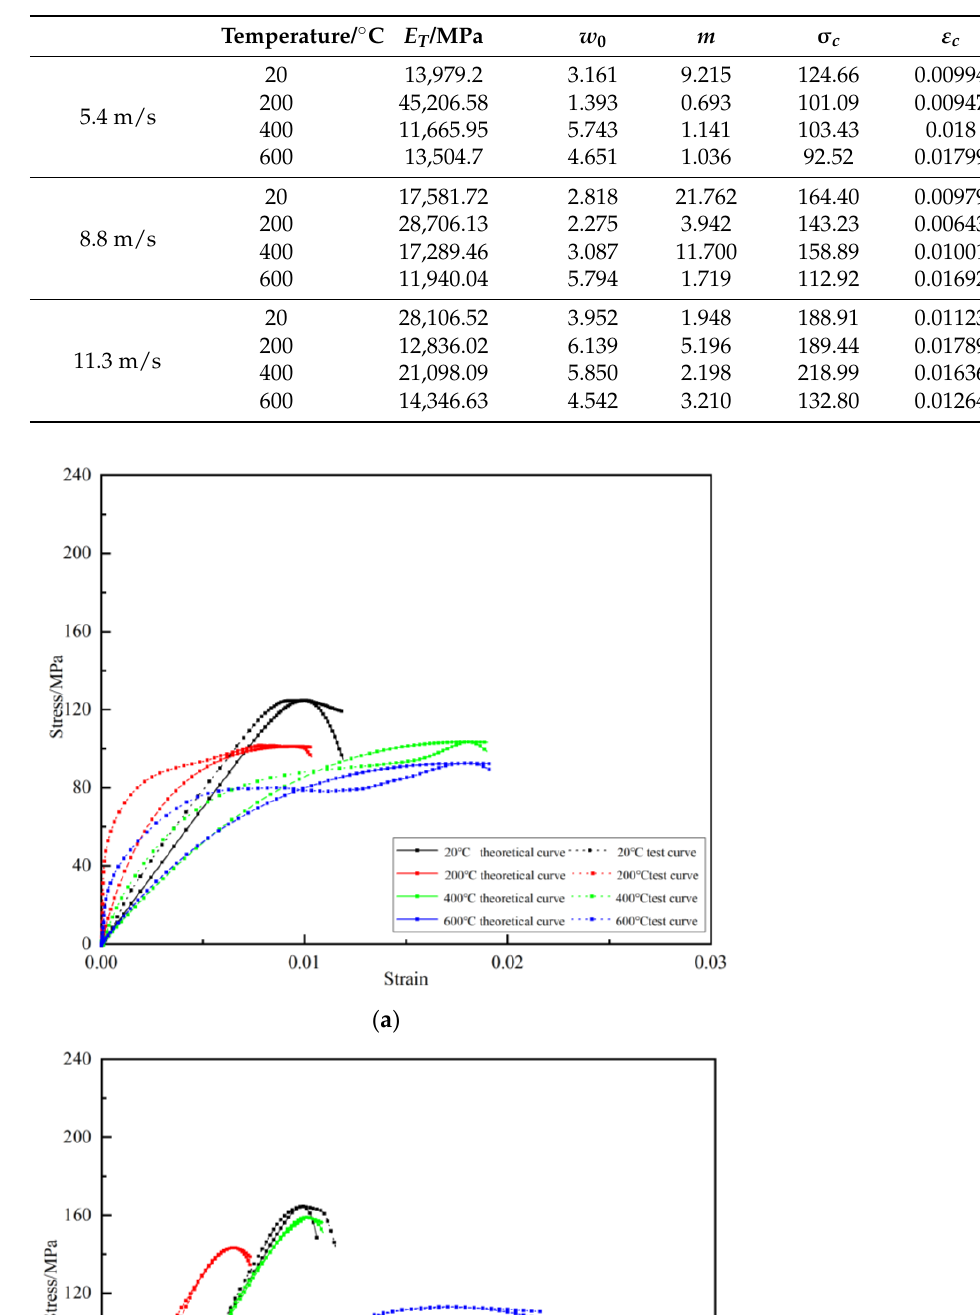
Table 1. Values of the model parameters.